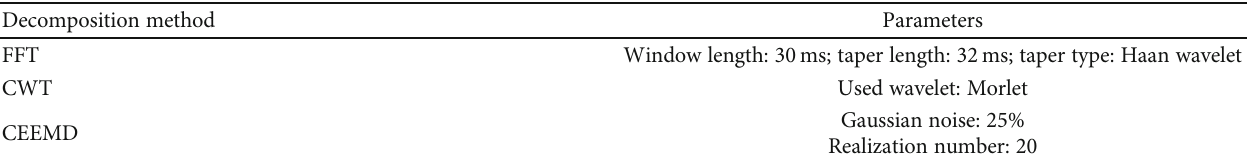
Table 1: Decomposition parameters used in the analysis.